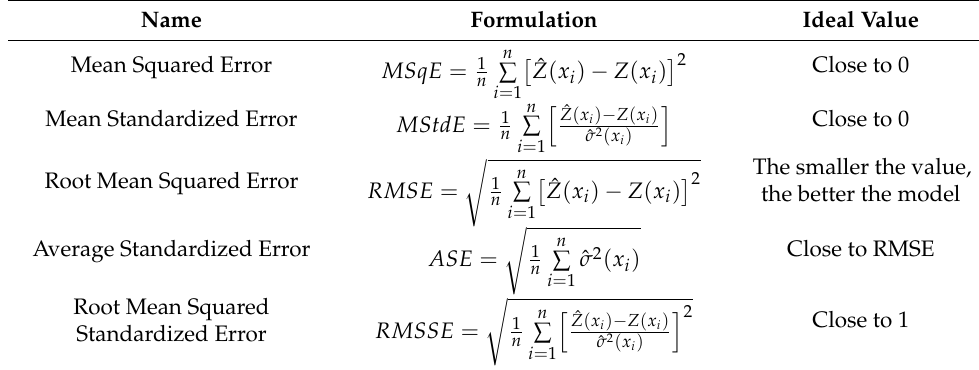
Table 3. Statistical measures for model